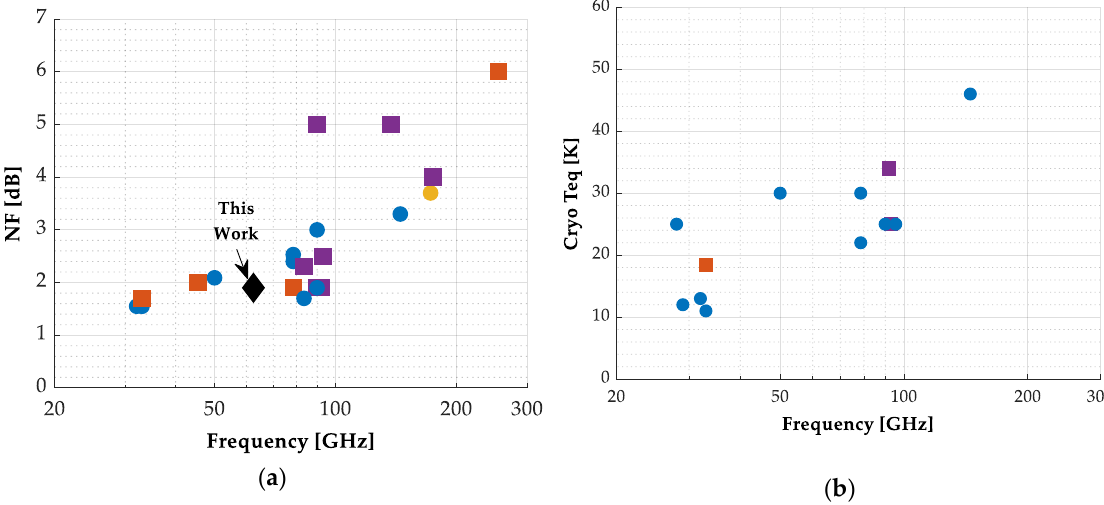
Figure 11. Noise figure at ambient temperature ( a ) and equivalent noise temperature in cryogenic environment ( b ) versus frequency of the works summarized in Table 2. LNAs are differentiated by technology and guiding structure. In detail: GaAs in microstrip (orange squares), GaAs in coplanar waveguide (purple squares), InP in microstrip (blue circles), and InP in coplanar waveguide (yellow circles). The black diamond represents the V-band LNA presented in this work and shown in Figure 10.